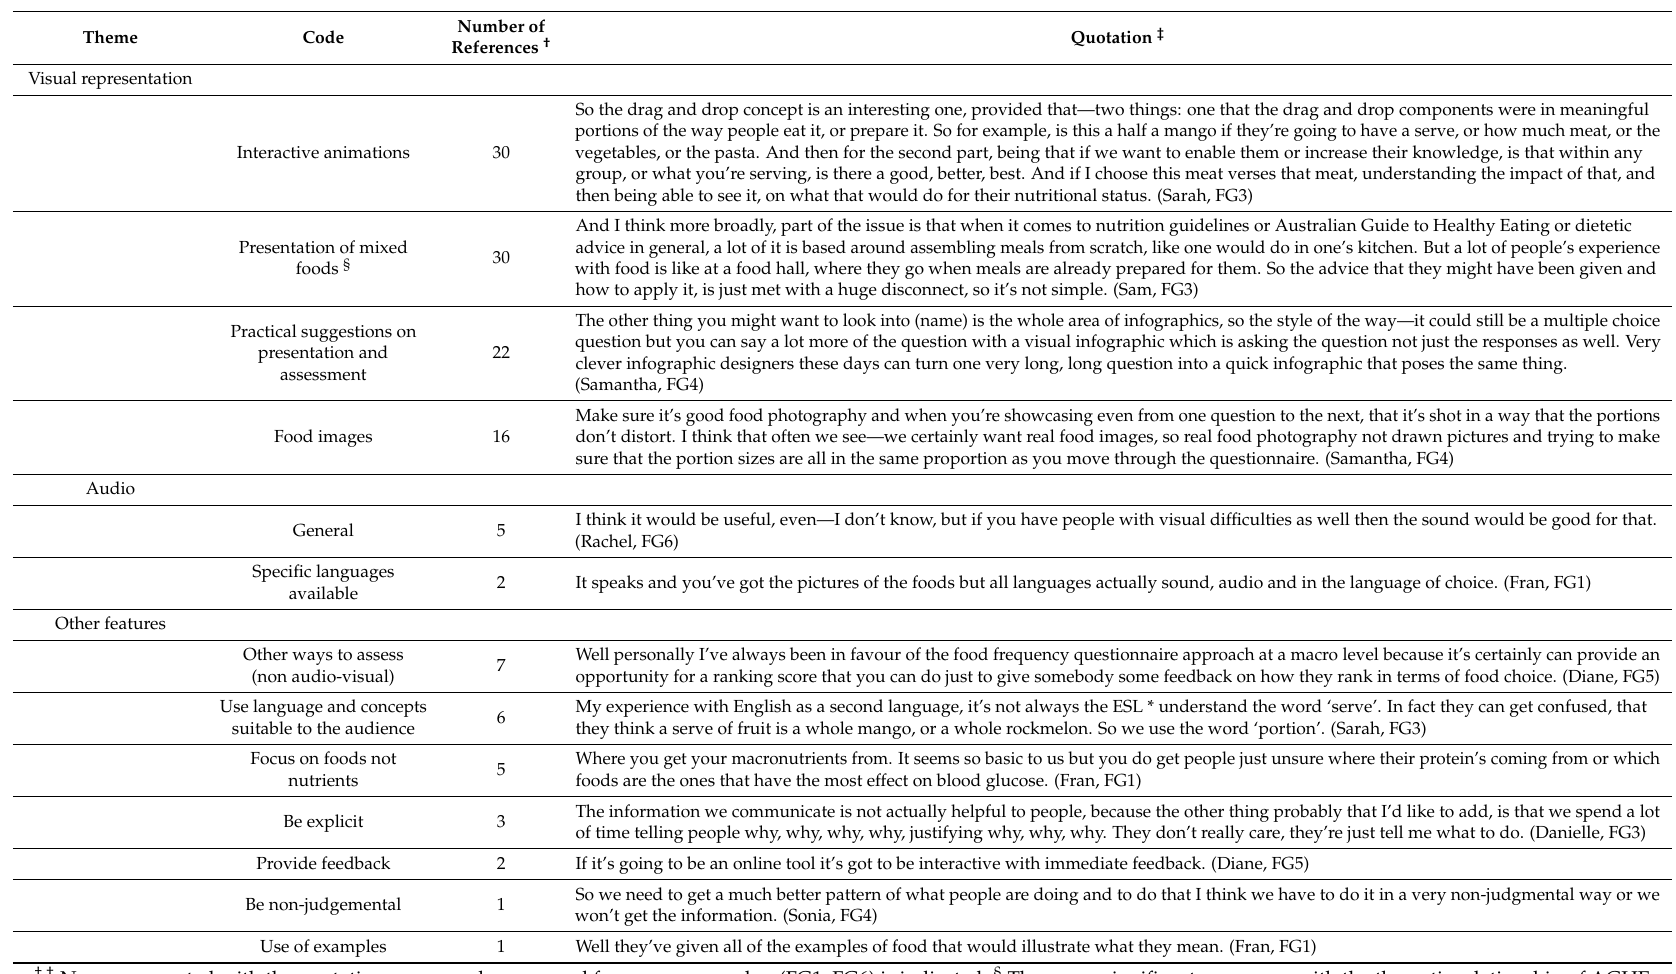
Table 4. Example quotations on presentation aspects of an electronic nutrition literacy